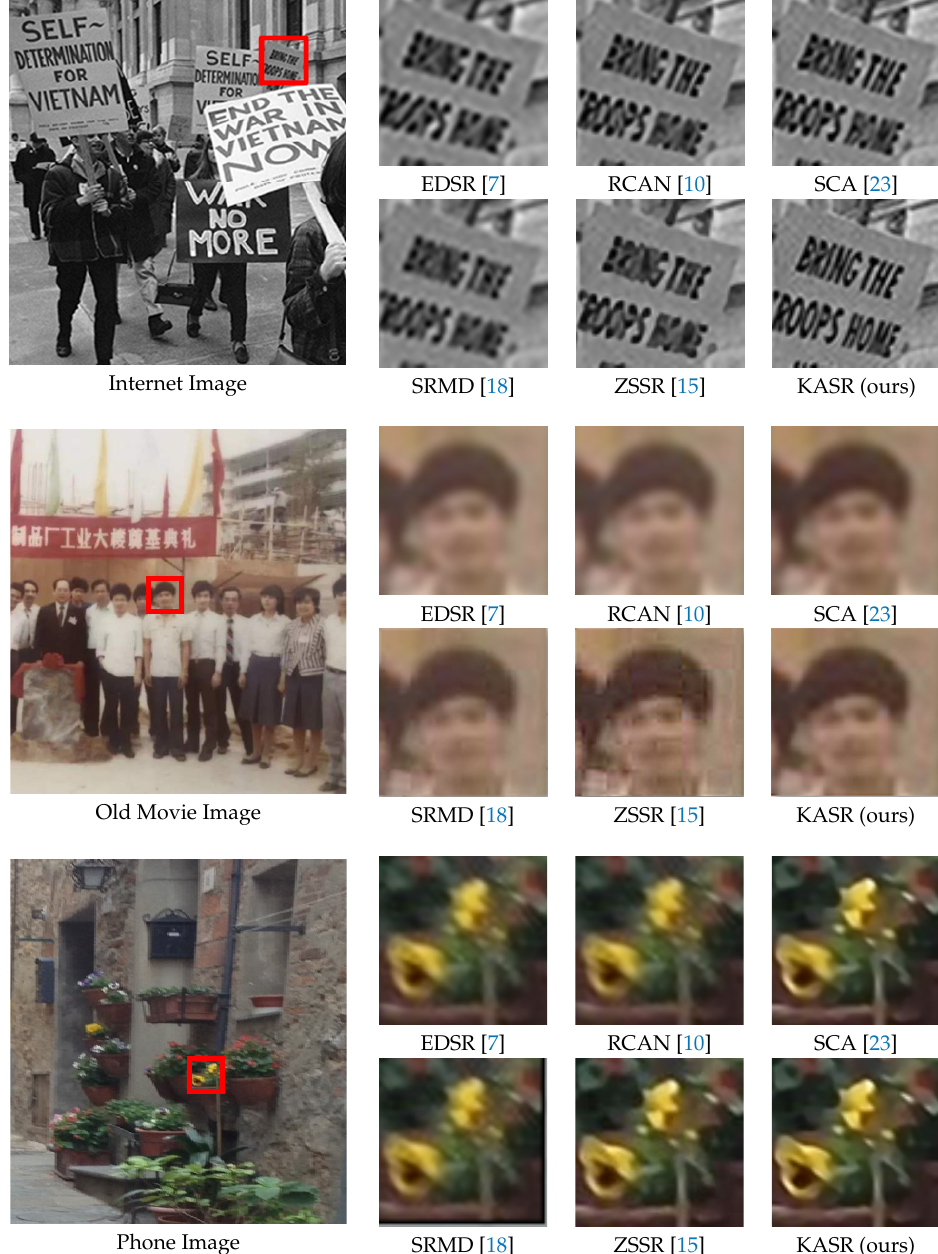
Figure 4. SR results ( × 3) of real world images (old movie image, phone image) by different